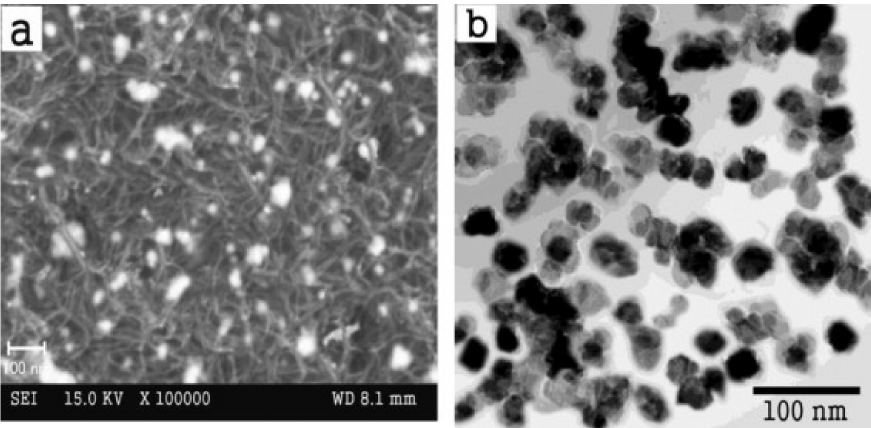
Figure 4. ( a ) SEM image of the MWNTs—Ni(OH) 2 nanocomposite film deposited on glassy carbon electrode (GCE); ( b ) TEM image of Ni(OH) 2 powder ( b ). Reprinted from [103] with permission of